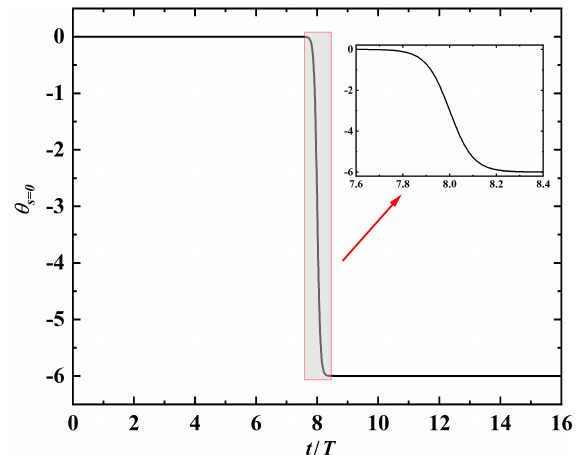
Figure 17. Variation of leading-edge deflection angle as a function of time in the turning maneuver. A enlarged view of the part of the curve in time interval [ 7.6, 8.4 ] is shown in the inset. The parameters used in performing the simulation of turning maneuver with θ max = − 6 ◦ are: k = 4 π , A = 200, Re = 100. Figure 18 shows the time history of the leading-edge’s ver- tical velocity. In the first seven periods, the time-averaged vertical velocity is approximately zero. This is indicative of steady straight-line swimming in the horizontal direction.